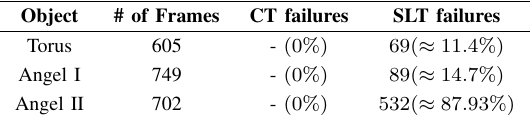
at: http://imd.naist.jp/videos/quadrics.html.